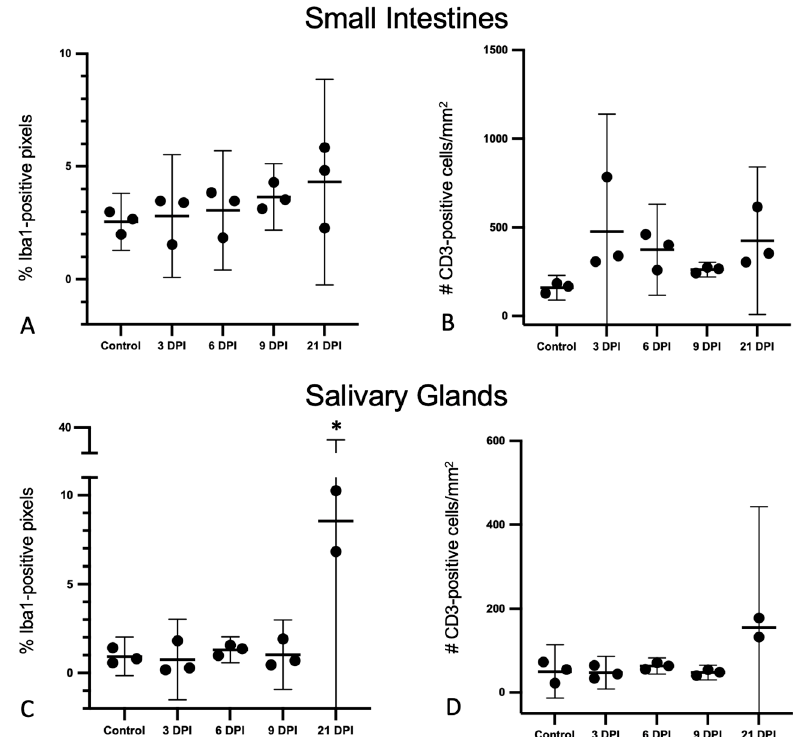
Figure 5. Iba1+ pixel percentages and CD3+ cell counts obtained by immunohistochemistry and whole-slide digital image analyses of the small intestines and salivary glands from SOSV-infected Egyptian rousette bats. Individual groups are represented on the x axis and each dot represents the score for a single bat. Bars represent the mean and lines represent the ±95% confidence interval. Control bats were euthanized at 21 DPI. ( A ) Percentage of Iba1-immunopositive pixels in the small intestines. ( B ) Number of CD3-immunopositive cells in the small intestines per mm 2 tissue. ( C ) Per- centage of Iba1-immunopositive pixels in the small intestines. The Iba1% positive pixel count was significantly increased in the salivary glands of SOSV-infected bats at 21 DPI relative to the controls (*). ( D ) Number of CD3-immunopositive cells in the small intestines per mm 2 tissue.